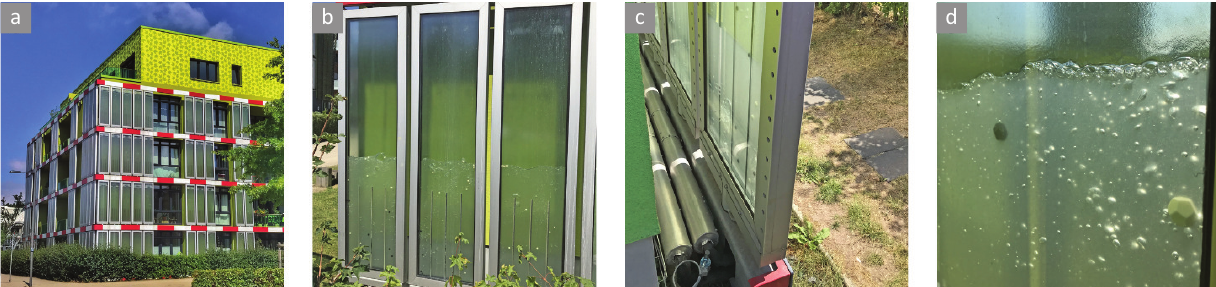
Figure 3. Bio‐Intelligent Quotient house in Wilhelmsburg, Hamburg: (a) facades; (b) photobioreactor panels; (c) and (d) details of the